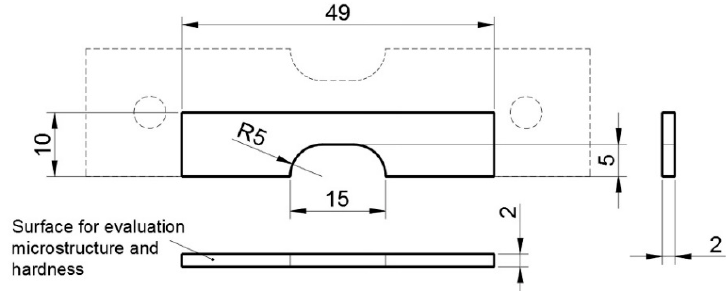
Figure 10. Sample with a reduced thickness of 2 mm used for the microstructure and hardness evaluation (unit: mm).